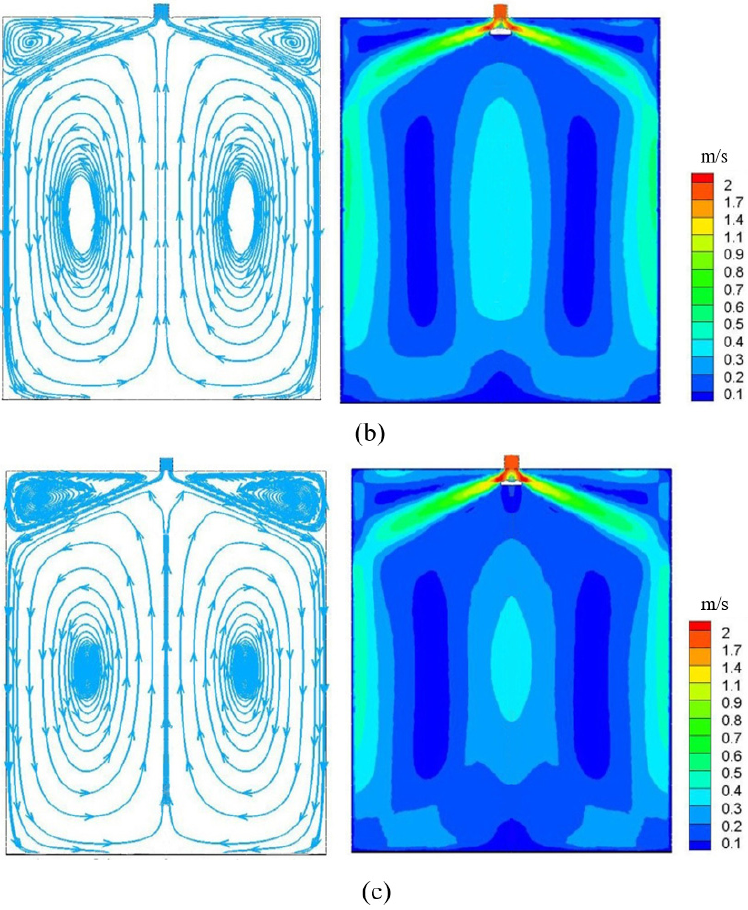
Figure 2. The trajectory line ( left ) and flow field ( right ) of ( a ) SEN A, ( b ) SEN B and ( c ) SEN C.